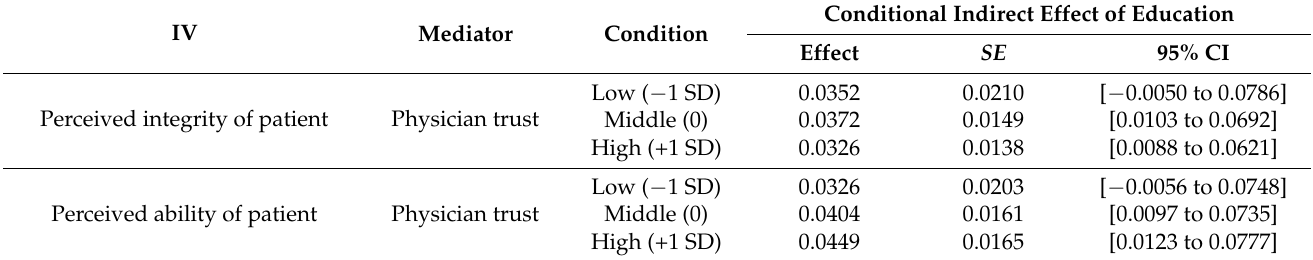
Table 2. Conditional indirect effect of perceived integrity and perceived ability of the patient on communication efficacy through physician trust moderated by